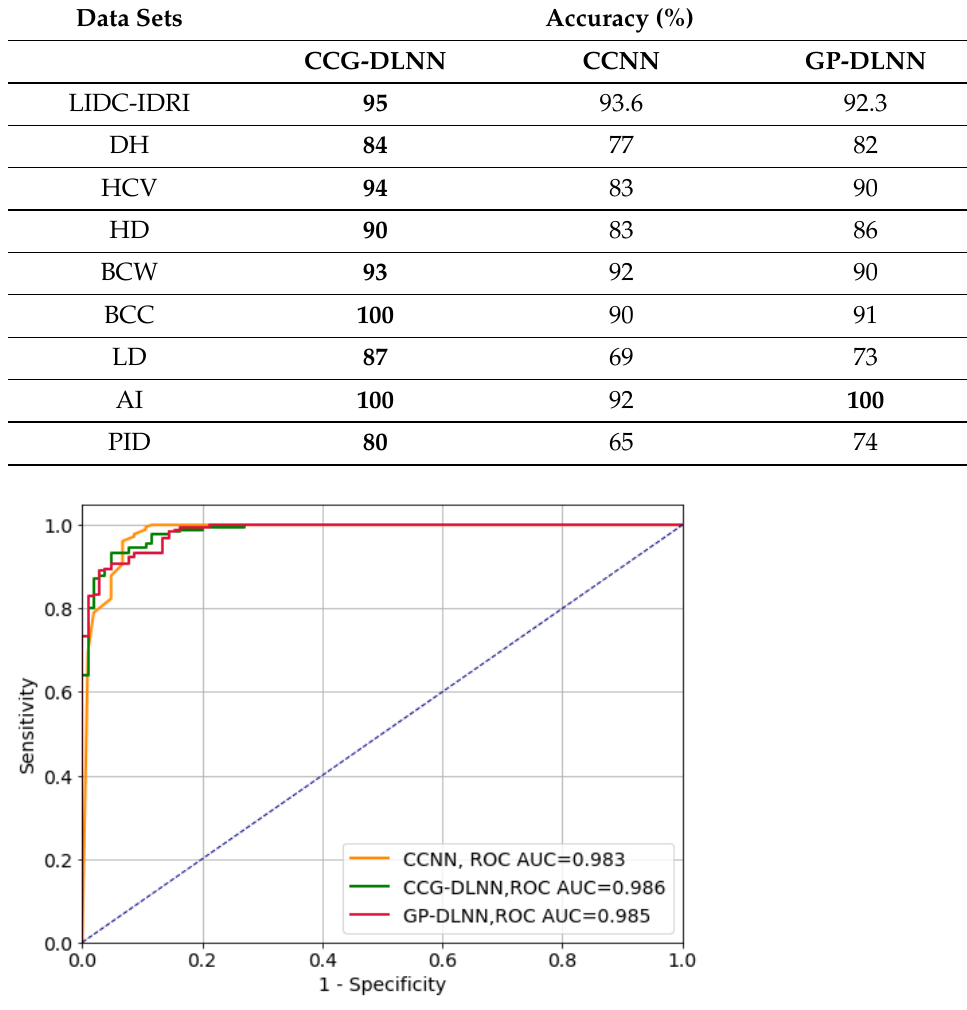
Figure 12. Curves of loss obtained by CCG-DLNN, GP-DLNN and CCNN on the LIDC-IDRI problem. Table 5. Summary of simulation results.